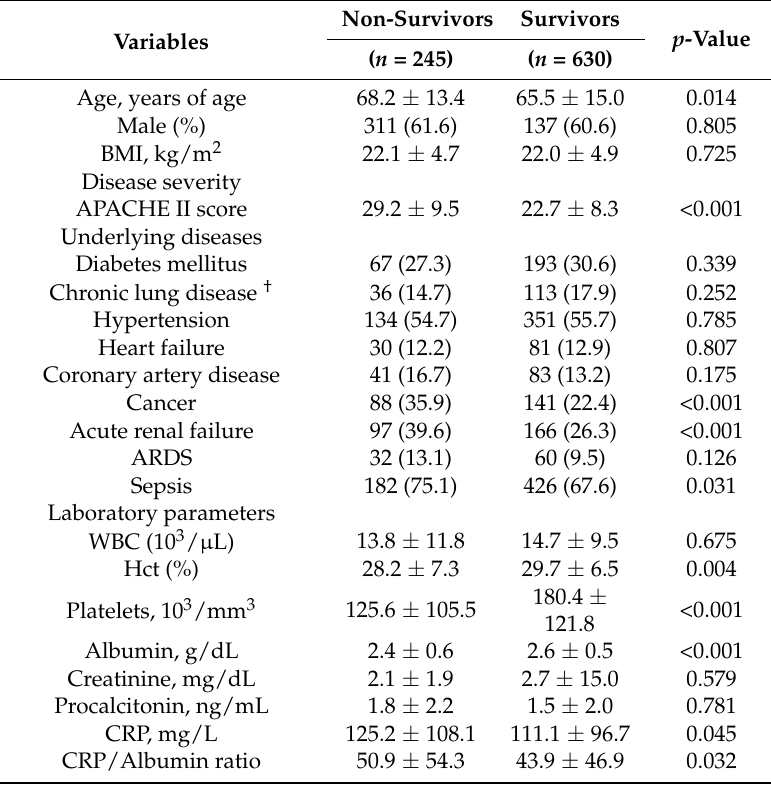
Table 1. Baseline characteristics of patients at day 0 of ICU admission *.